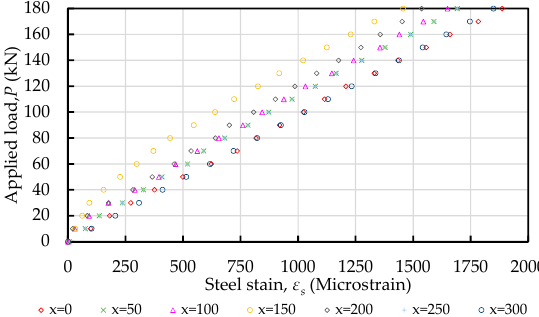
Figure 7. Applied load and steel strain relationship (taking concrete C20 as an example).